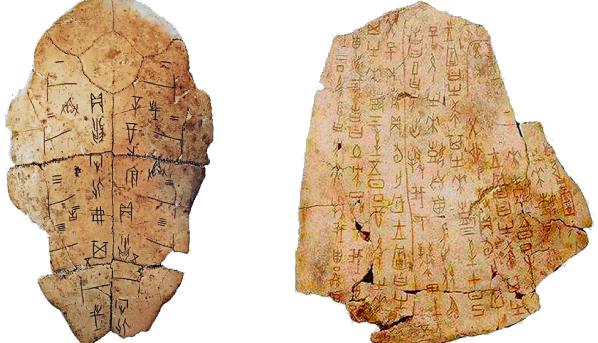
Figure 1. The abdominal parts of two tortoise shells with divinatory inscriptions excavated at the site of Yinxu, Anyang, Henan,